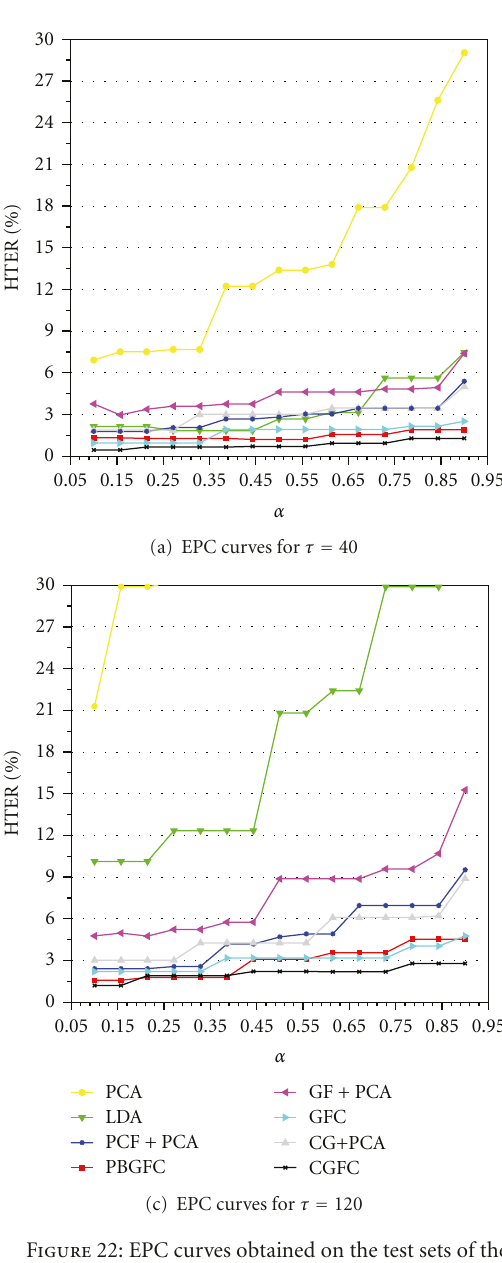
technique and our own implementations of seven